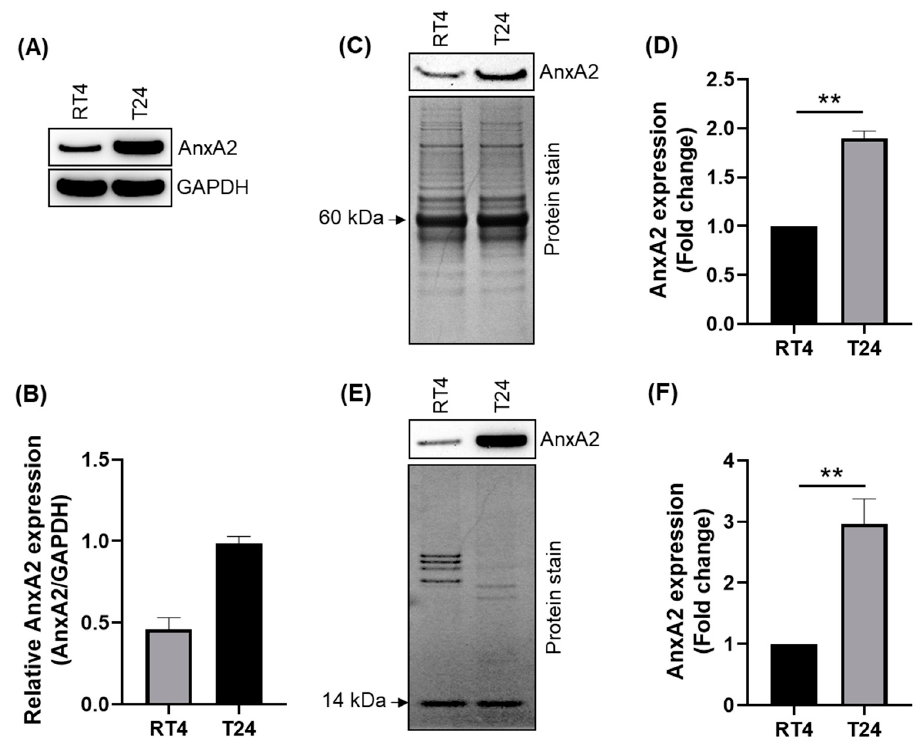
Figure 3. AnxA2 expression in human bladder cancer cell lines. ( A ) Endogenous AnxA2 protein was analyzed by immunoblot analysis in RT4 and T24 bladder cancer cell lines. Glyceraldehyde-3-phosphate dehydrogenase (GAPDH) was used as a loading control. ( B ) The intensity of AnxA2 was determined by densitometry and normalized by loading control. ( C ) Cell surface expression of AnxA2 in bladder cancer cells was analyzed by a membrane wash experiment. Cells were incubated with Versene for 5min, and then the supernatant was collected by centrifugation for immunoblot analysis. SDS-PAGE was performed with identical protein concentrations to normalize for loading, and the gel was stained with Coomassie Blue. ( D ) Densitometric analysis was performed to compare the fold change in AnxA2 expression. ( E ) The cell surface biotinylation was performed as described in the material and methods. The extracts were immunoblotted with an anti-AnxA2 antibody. Coomassie Blue staining was performed for loading control. A ∼ 14-kD, Coomassie-stained band, whose levels seemed invariant in both cell lines, was used to account for differences in protein loading. ( F ) The intensity of AnxA2 was performed by densitometry, and fold change in AnxA2 expression was determined. **, p < 0.01. Uncropped Western Blots of ( A , C , E ) are available in File